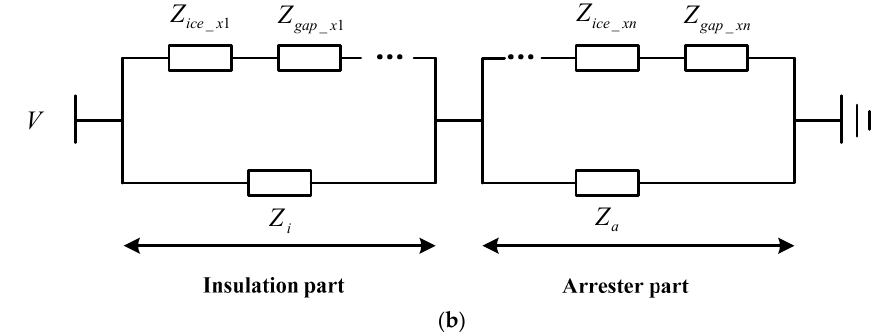
Figure 10. Equivalent circuit models of the iced insulators. ( a ) Type D; and ( b ) Type F.